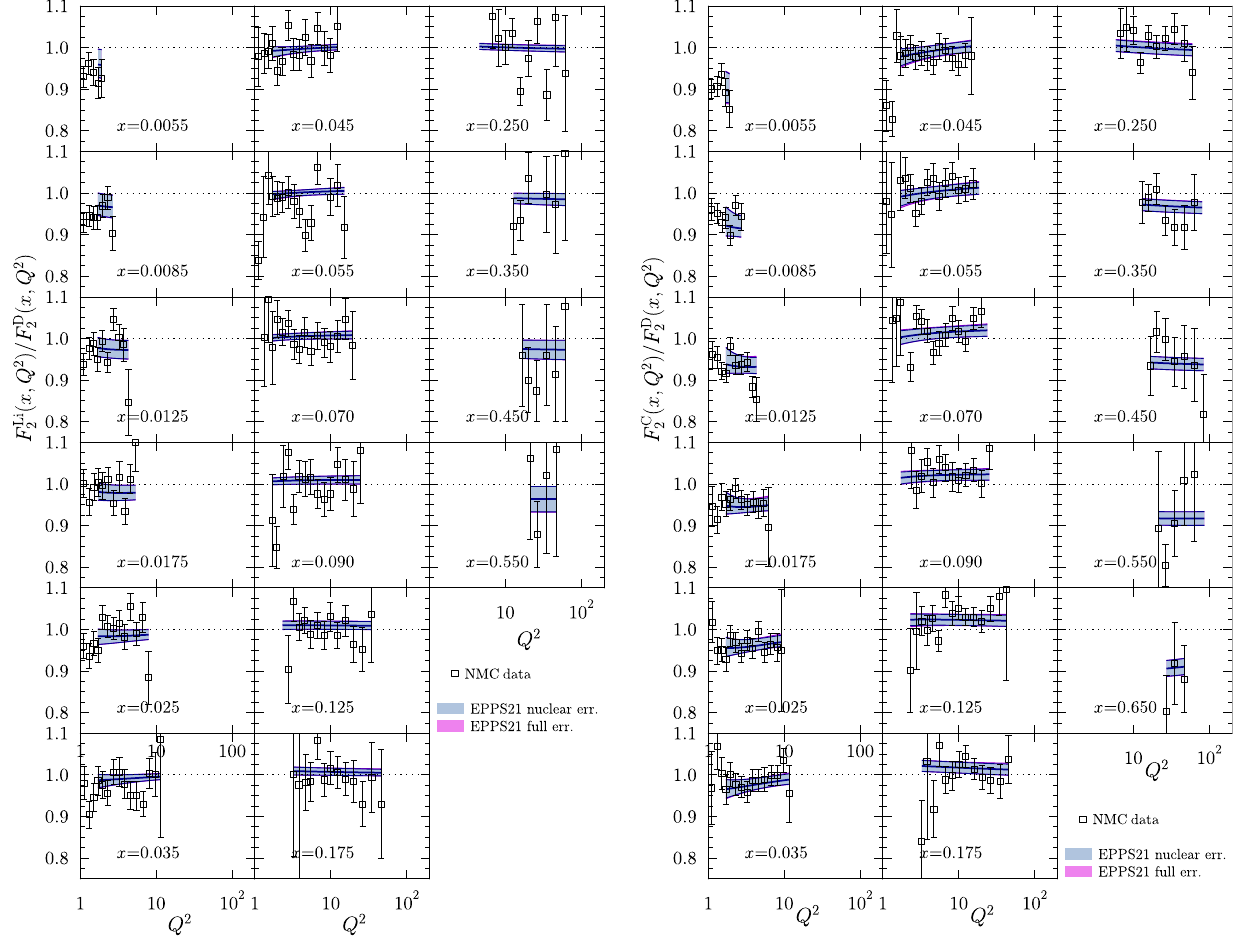
Fig. 18 The Q 2 -dependent NMC structure–function ratios [45] compared with the EPPS21 analysis. The solid blue curves show our central results, inner blue bands the nuclear uncertainties, and the purple bands the total